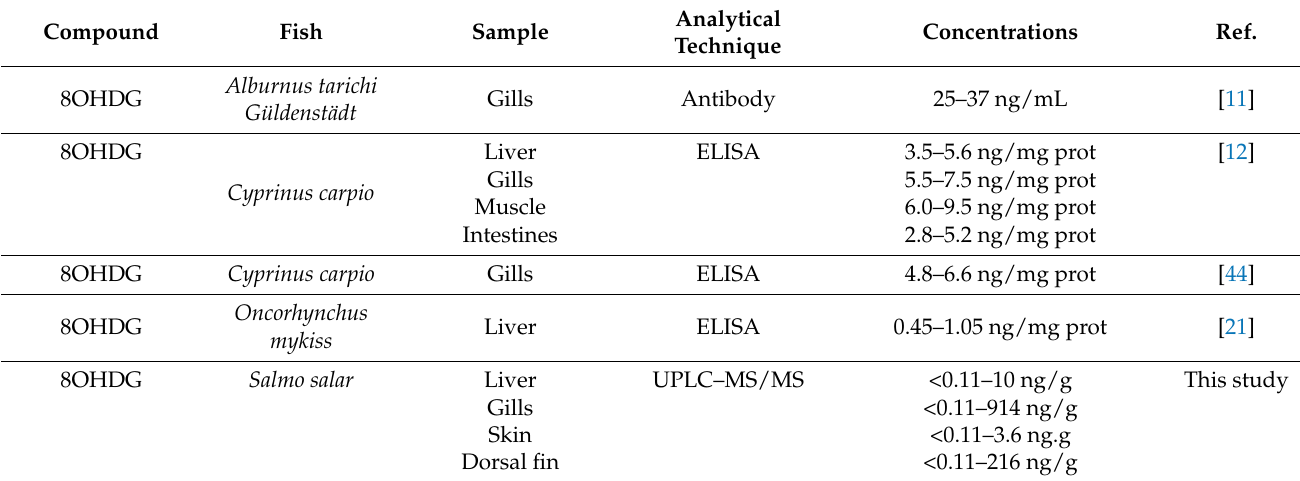
Table 4. Reported concentrations of 8OHDG in fish